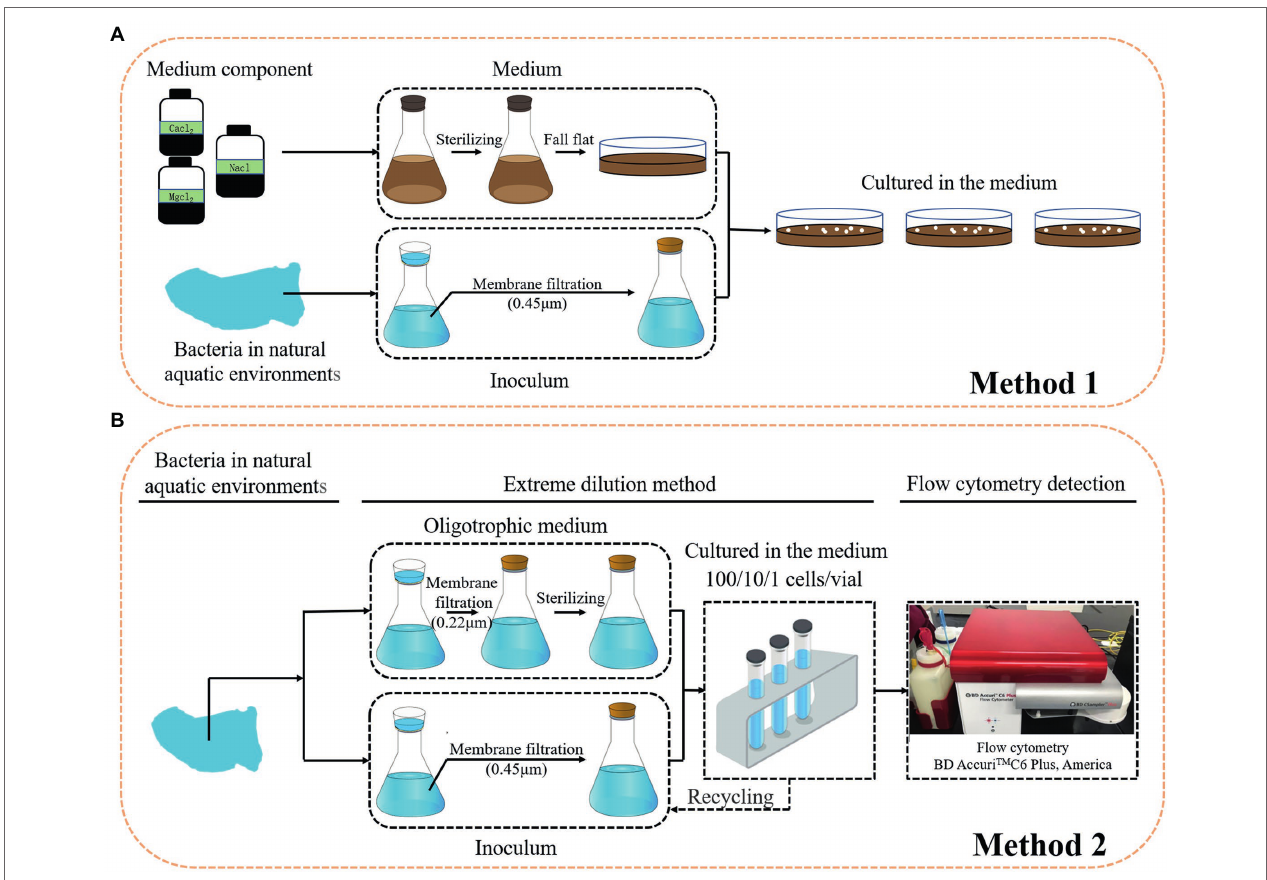
FIGURE 4 | Cultivation strategies for LNA bacteria. (A): conventional cultivation; (B): dilution cultures, filtration and